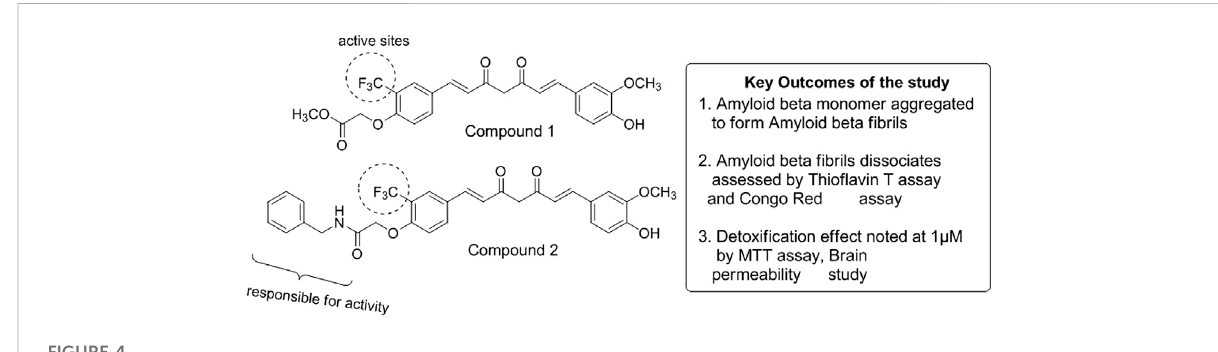
FIGURE 4 Mechanistic study of curcumin in